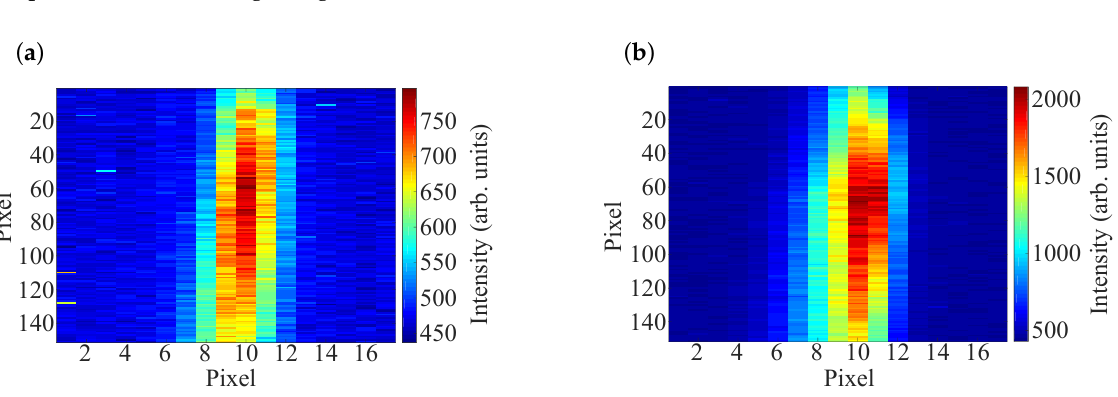
Figure 7. Acquired CCD images at the image plane of two emission lines selected by the G 1 grating. ( a ) 13.48 eV; and ( b ) 21.22 eV.